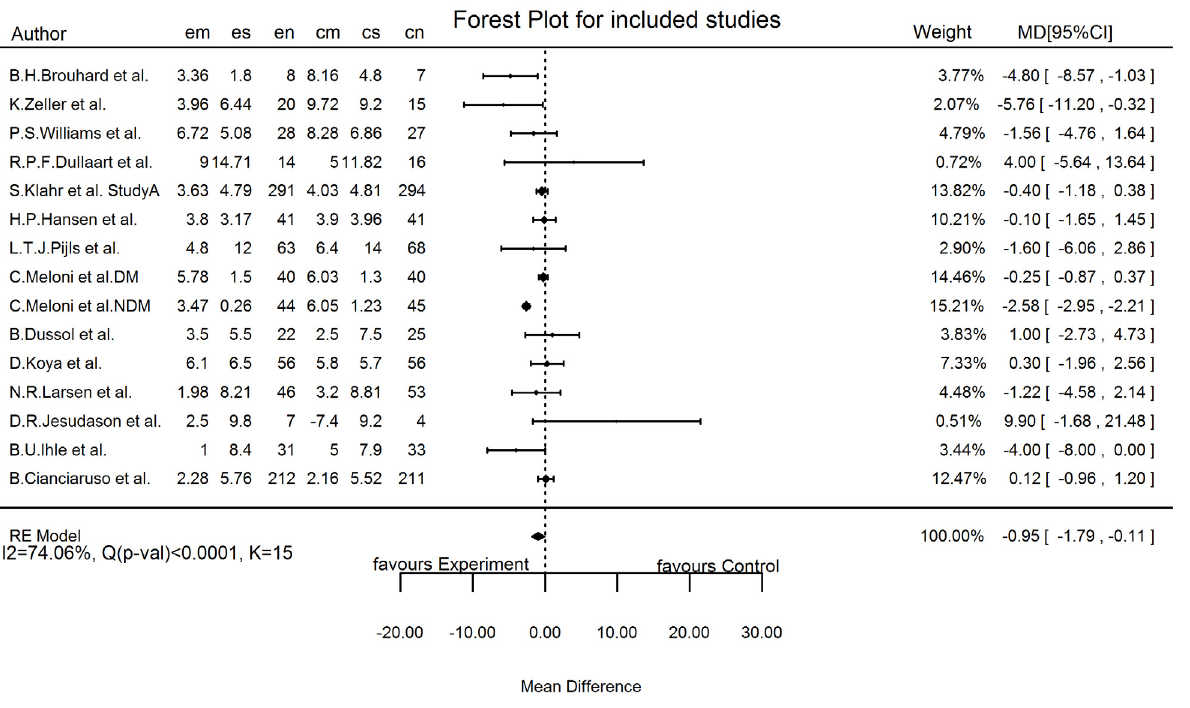
Fig 2. Forest Plot of all the included studies a . The forest plot for all included studies pooled together using a random-effects model. a em, mean decline in experimental group; es, standard deviation in experimental group; en, number of subjects in experimental group; cm, mean decline in control group; cs, standard deviation in control group; cn, number of subjects in control group, MD, mean difference; I2, variability due to heterogeneity; Q, chi-square test; K, number of included